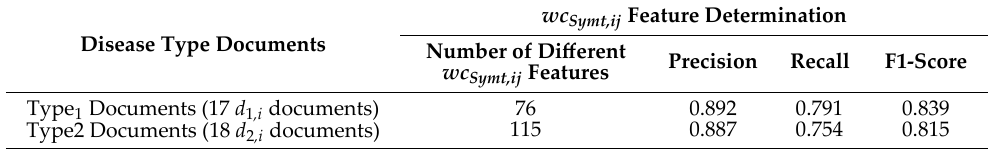
Table 5. The wc Symt,ij Feature Determination from the first test sample based on Medical-Symptom- Expression List on Wikipedia.